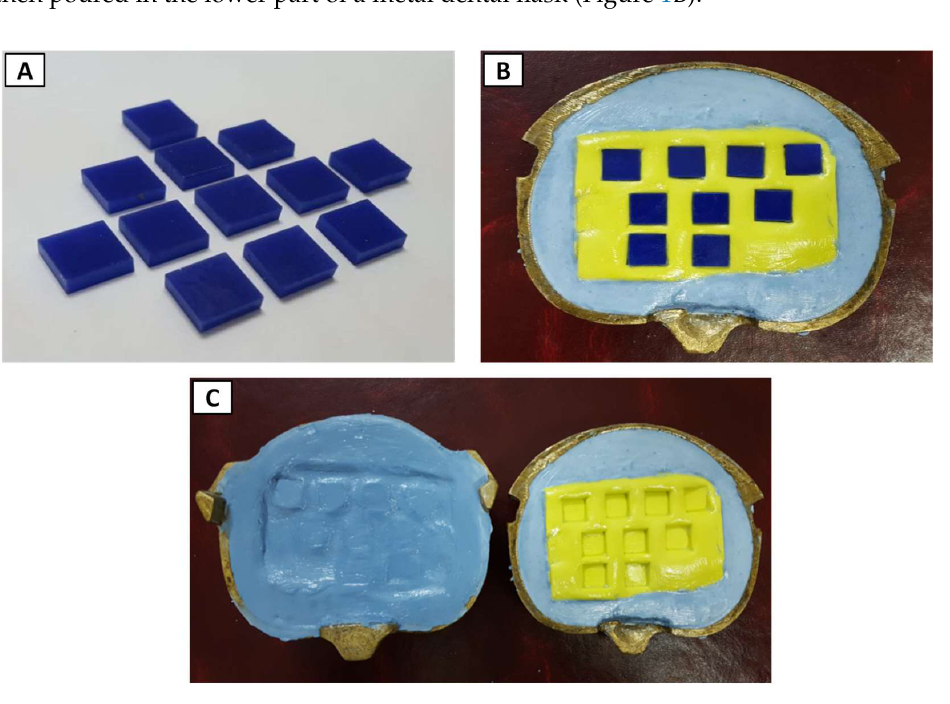
Figure 1. ( A ) Plastic pa(cid:308)erns and ( B ) plastic pa(cid:308)erns imbedded in silicone mold and stone, and ( C